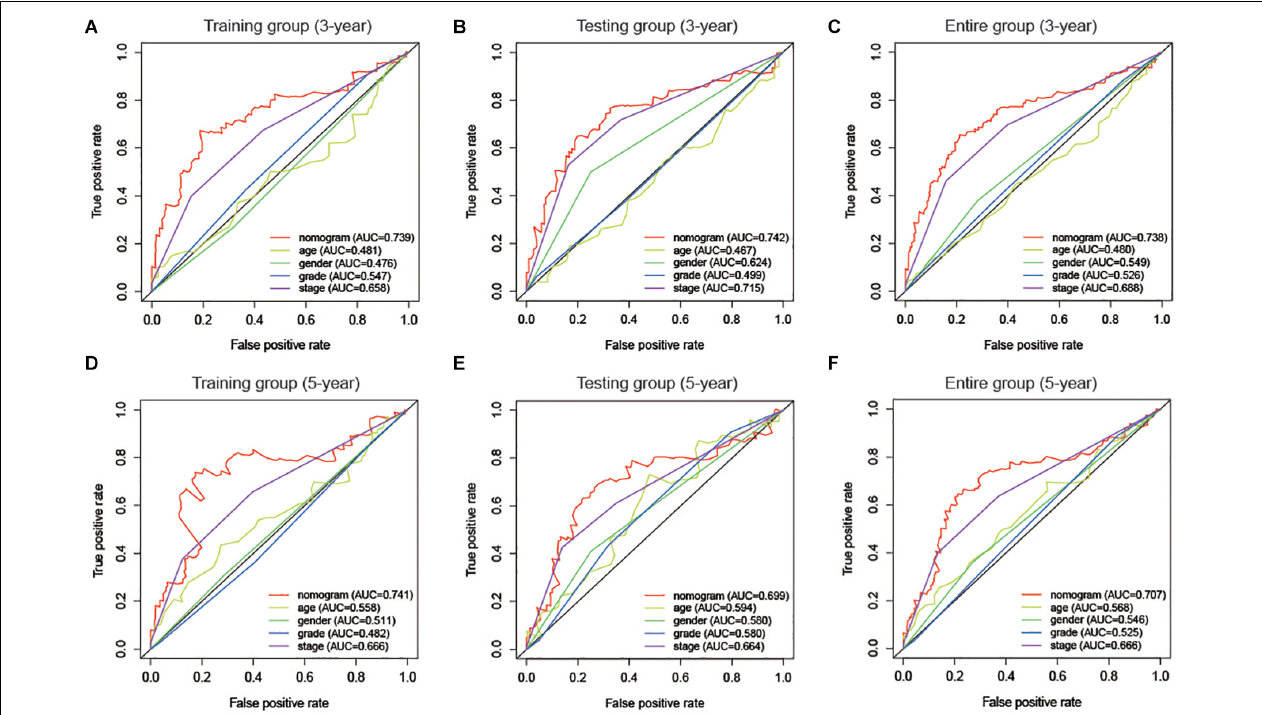
FIGURE 7 | Time-dependent ROC curve analysis for the nomogram and the clinicopathological features in the training group (A,D) , testing group (B,E) , and the entire group (C,F) .